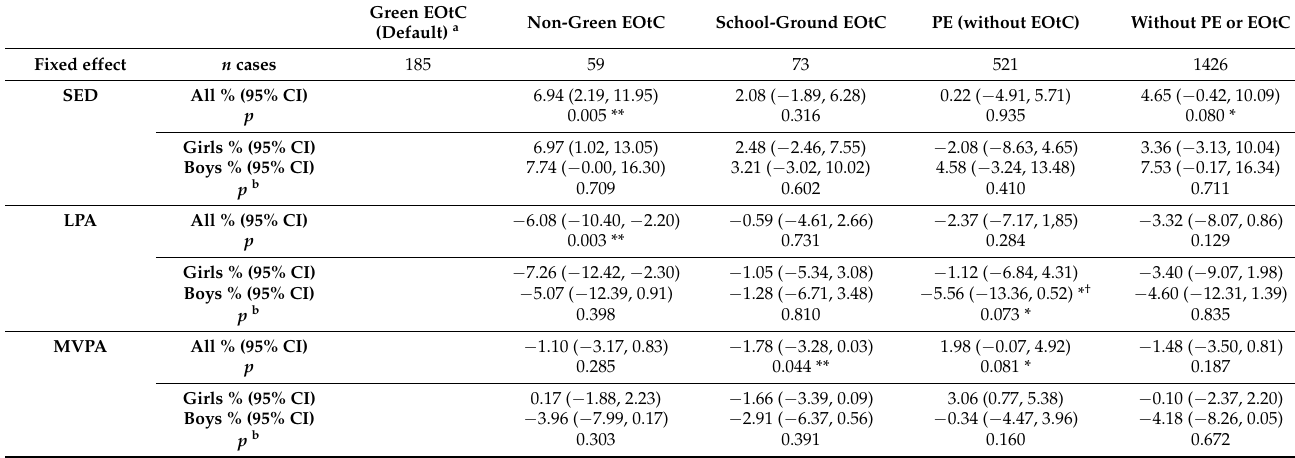
Table 1. Proportion of school days spent in SED, LPA and MVPA in different school day setting categories. Green EOtC (Default) a Non-Green EOtC School-Ground EOtC PE (without EOtC) Without PE or